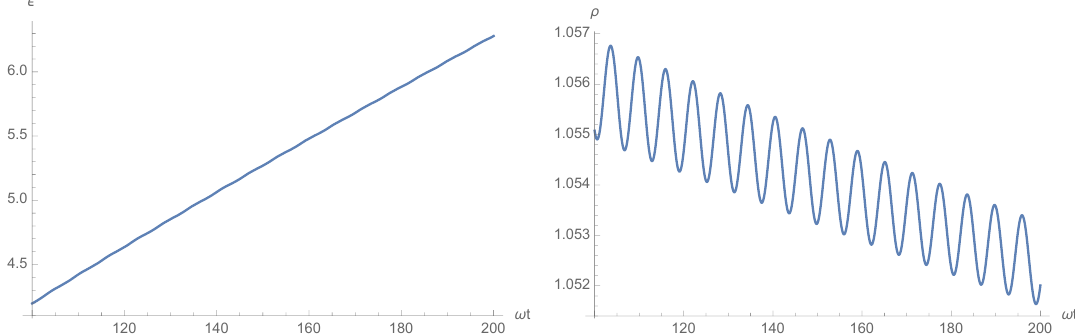
Figure 5 . The energy density (left) and charge density (right) as a function of time. Due to absence of a heat bath the energy density increases over time.